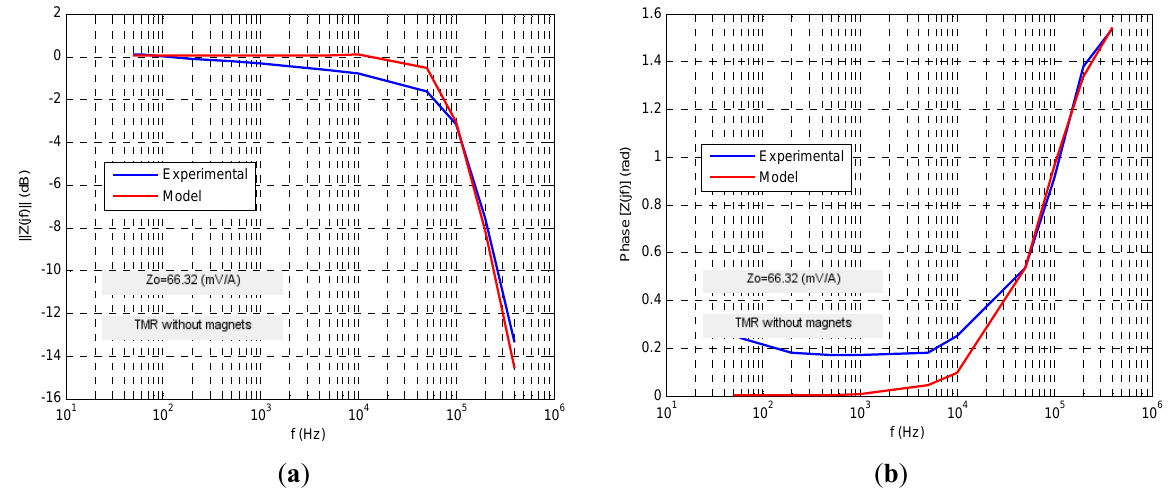
Figure 13. TMR sensor without internal magnetization ac large-signal fractional modeling.